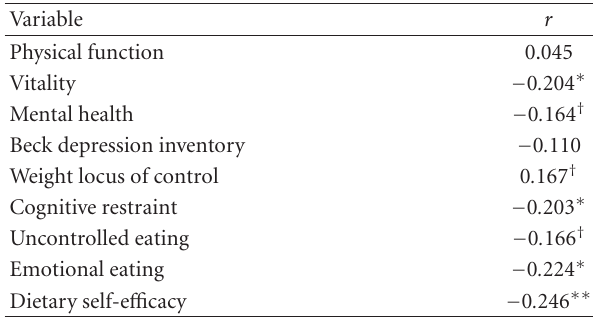
Table 2: Simple correlations between RPE and questionnaire